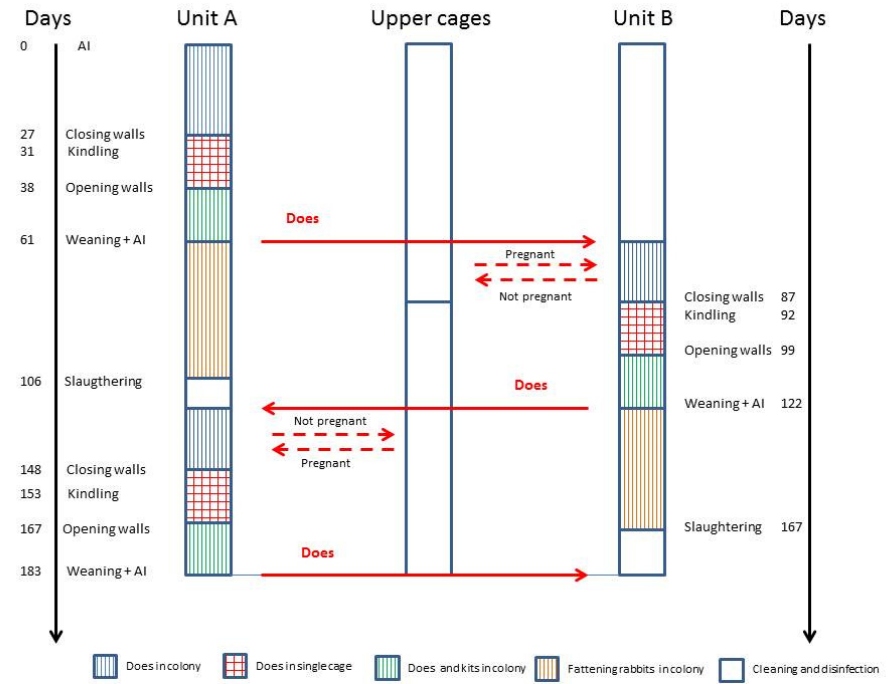
Figure 4. Scheme of rabbit production protocol of C2 cages. The production cycle is closed: non-pregnant does were housed in the upper cages, and young rabbits after weaning were kept in unit A or B, alternatively.